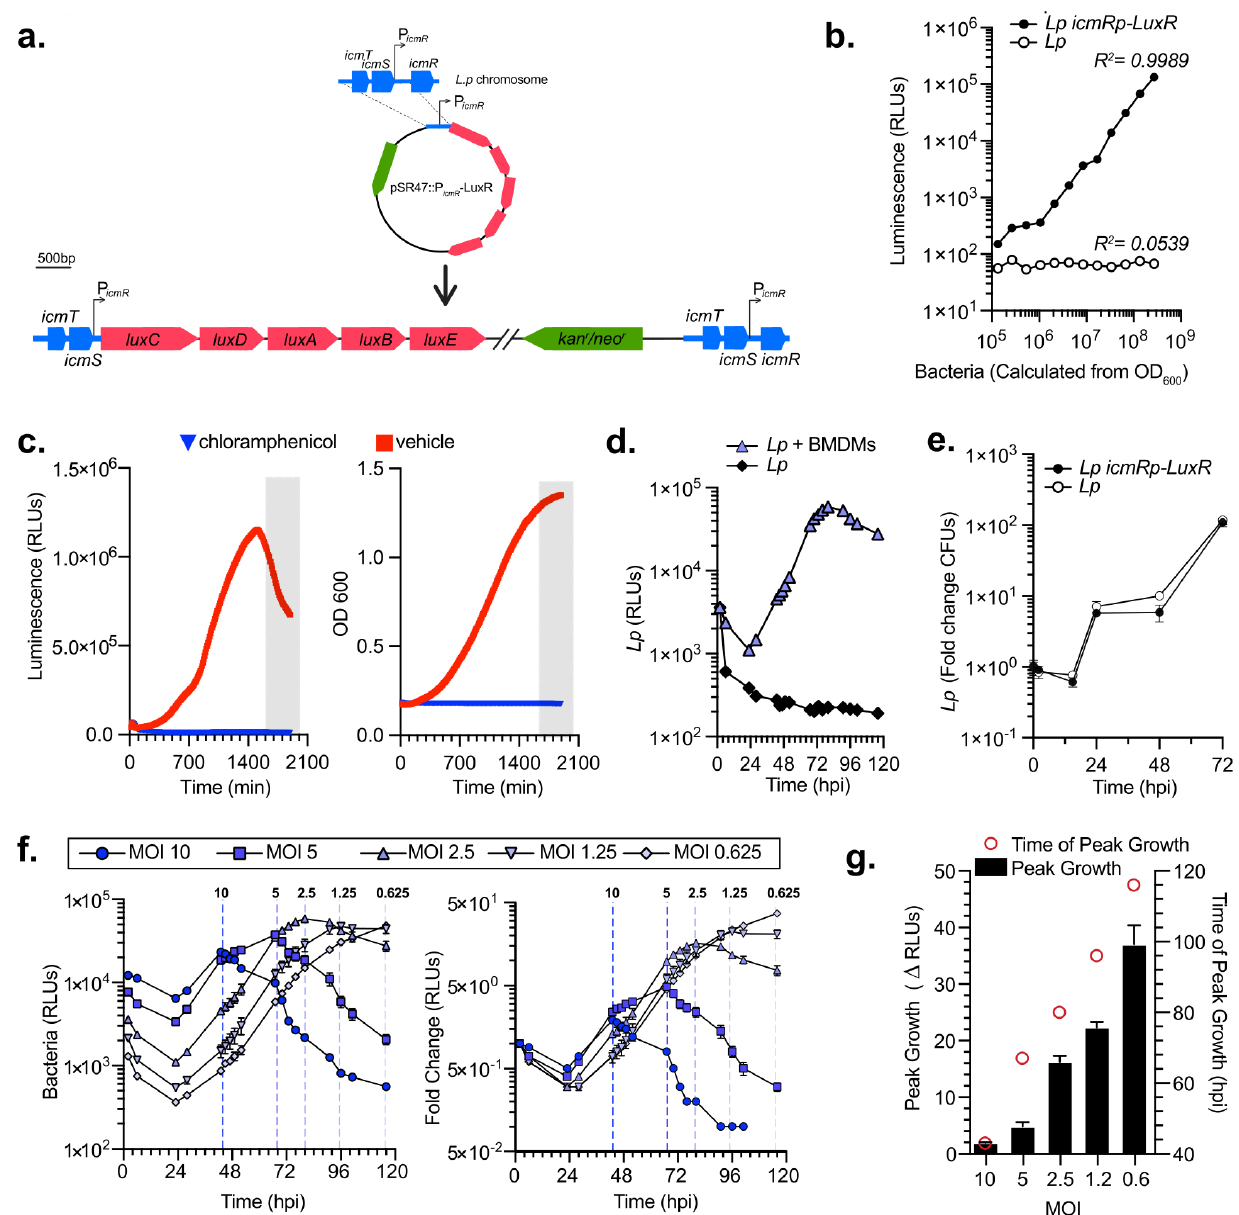
FIGURE 1: Construction and characterization of L. pneumophila strain encoding the LuxR operon. (a) Construction of the Lp icmRp - LuxR strain via single homologous recombination event with the suicide plasmid pSR47:: icmRp - LuxR , which encodes the LuxR operon cloned downstream of a 863 nt region of homology containing the icmR promoter region from the Lp01 strain. (b) Luminescence output of the LuxR-encoding Lp as compared to the parental strain. Simultaneous luminescence and optical density measurements are shown from serial dilutions prepared from two-day heavy patches grown on CYA plates. (c) Luminescence output of the Lp icmRp - LuxR measured every ten min in axenically grown AYE liquid cultures in the presence/absence of chloramphenicol over the indicated time period. Each time point represents an average of a tech- nical triplicate. (d) Bacterial growth of Lp icmRp - LuxR measured from bioluminescence output when bacteria were cultured in the absence or presence of BMDMs. (e) Growth comparison between in the indicated Lp strains in BMDMs infections measured by a CFU growth assay. (f) Growth kinetics of Lp icmRp - LuxR is shown for various MOIs. A vertical line indicates the peak of the growth curve for each infection. (g) The peak time and amplitude of the growth curve for each MOI from (f) are shown. (d-g) Each data point represents an average from technical triplicates  SD. (b-g) Representative data from one of three biological replicates are